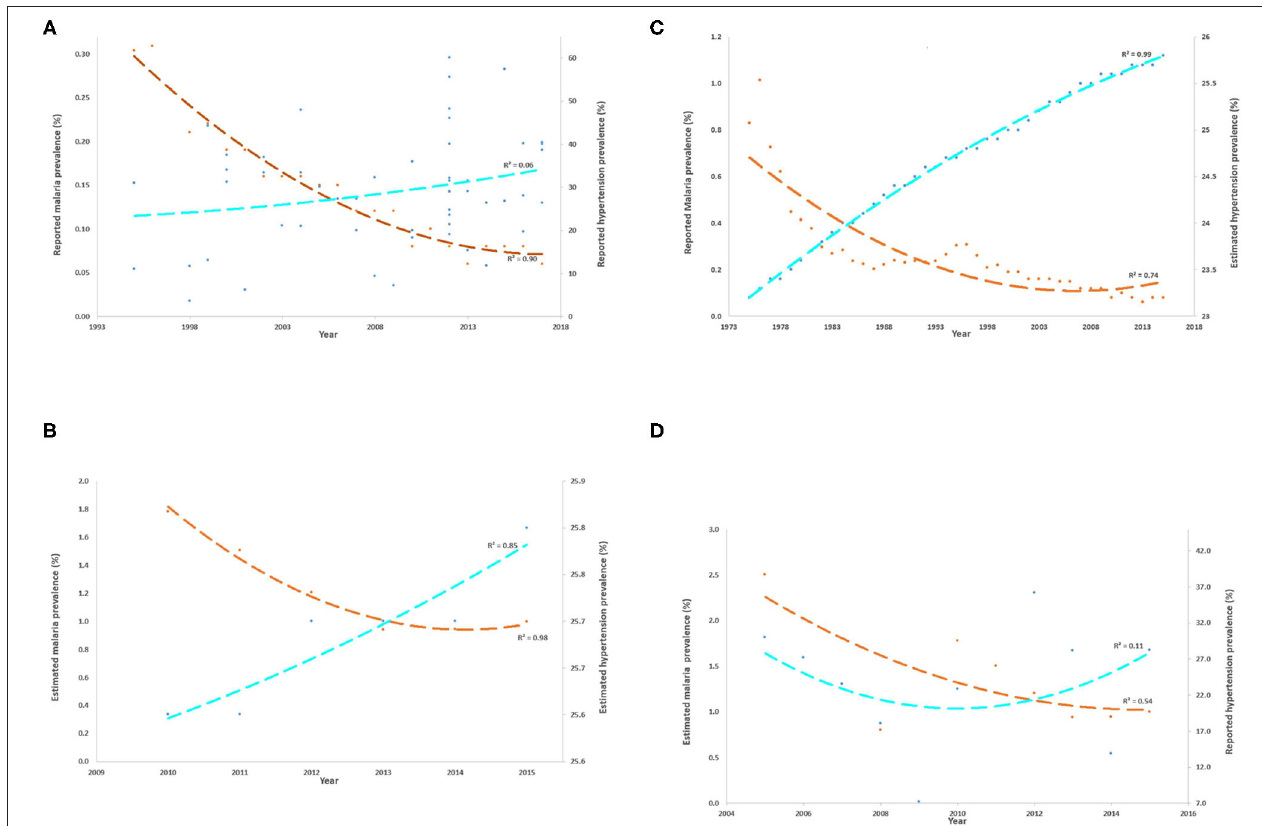
FIGURE 1 | (A–D) Inverse trends of reported and estimated burdens of malaria and hypertension in India across various years. The burdens of malaria (Y-axis) and hypertension (secondary Y-axis) are represented as percentage prevalence and the best-fit polynomial trend line (order = 2) is plotted for each, orange dashed line for malaria and fluorescent blue dashed line for hypertension. The calculated R 2 value of the best fit line is also shown. (A) shows the reported malaria and hypertension burden in India between 1994 and 2017 as per the published data whereas (B) shows the estimated burden of both diseases from 2010 to 2015. The low R 2 value for reported data on hypertension is probably due to the differences in study designs and surveys that reported such data. In addition, because estimated malaria prevalence could not be retrieved beyond 2005 in the past, reported malaria prevalence was also plotted against estimated hypertension prevalence (C) and estimated malaria prevalence was plotted against reported hypertension prevalence (D) . In all the analyses, it was evident that malaria and hypertension prevalence trends over the years are inversely related in India: the increasing hypertension prevalence is associated with a decreasing prevalence of malaria, although the rate of change is different for both the